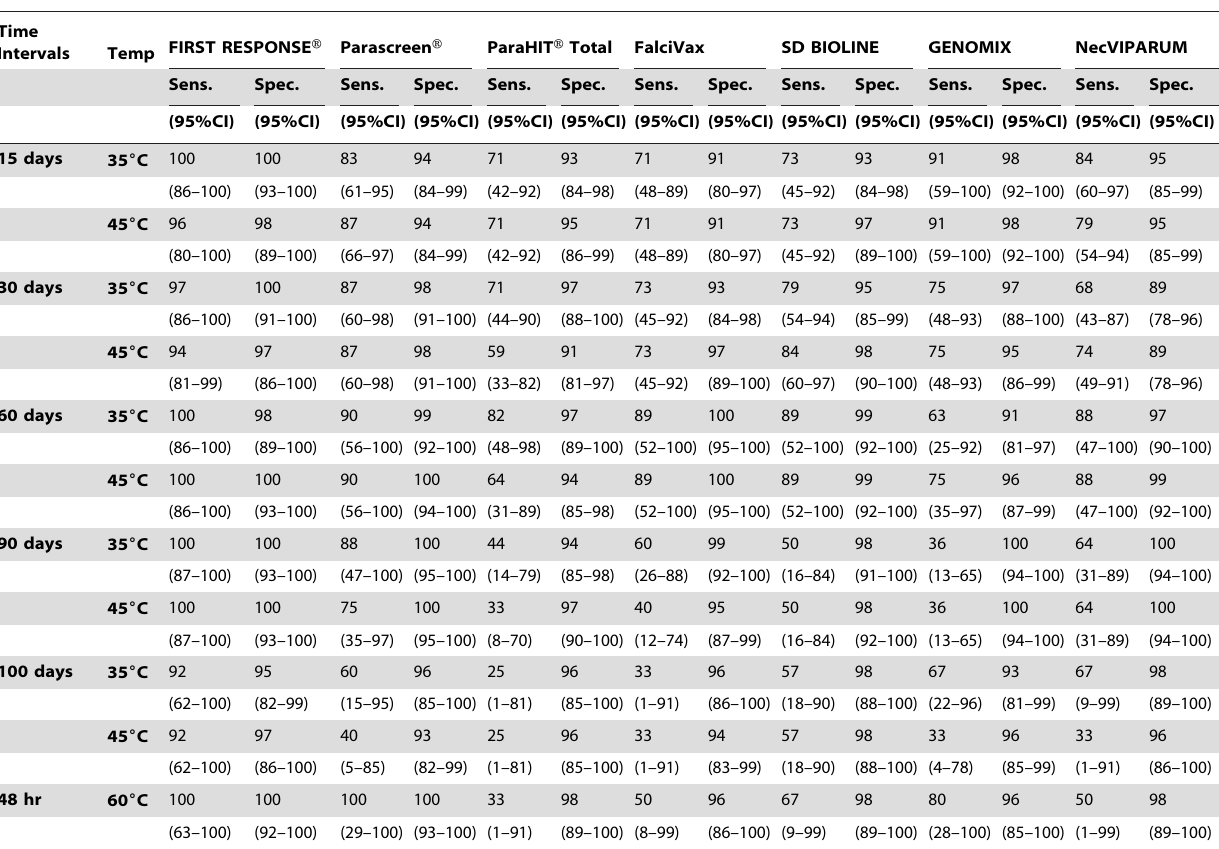
Table 4. Sensitivity of 7 different RDTs at 35 u C, 45 u C and 60 u C for P. vivax against Room Temperature.